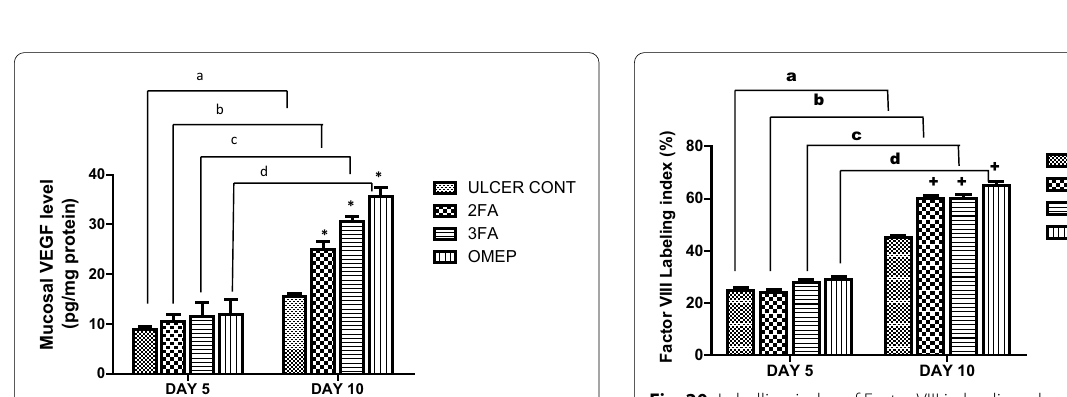
Fig. 20 Labelling index of Factor VIII in healing ulcerated stomach Fig. 19 Effect of folic acid supplementation on vascular endothelial treated with folic acid and Omeprazole (* p < 0.05 cf ulcer control; growth factor (VEGF) levels in healing ulcerated gastric mucosa. a–d p < 0.05 cf. each group on day 10). ULCER CONT Acetic acid = (* p < 0.05 cf ulcer control; a–d p < 0.05 cf. each group on day 10). Ulcer control, 2FA 2 mg/kg Folic acid, 3FA 3 mg/kg Folic acid, = = ULCER CONT Acetic acid Ulcer control, 2FA 2 mg/kg Folic acid, OMEP Omeprazole = = = 3FA 3 mg/kg Folic acid, OMEP Omeprazole = = Ki-67 expression has also been associated with gastric epithelial cell function. The protein is present during all presence on the cell clearly signify that they are the tar- active phases of the cell cycle (G(1), S, G(2) and mitosis), gets for the proliferation stimulating action of EGF (Slo- but absent in the resting cells G(0), making it an excellent miany et al., 1998; Tarnawski, 2005a, 2005b). Similarly,